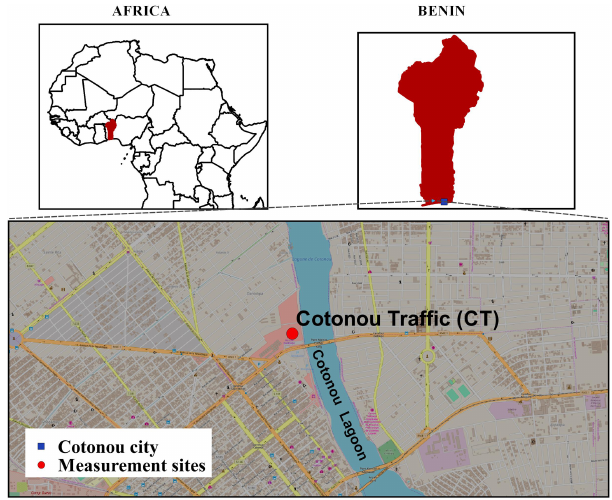
Figure 2. Map of the city of Cotonou reporting the geographical location of DACCIWA urban sampling site.